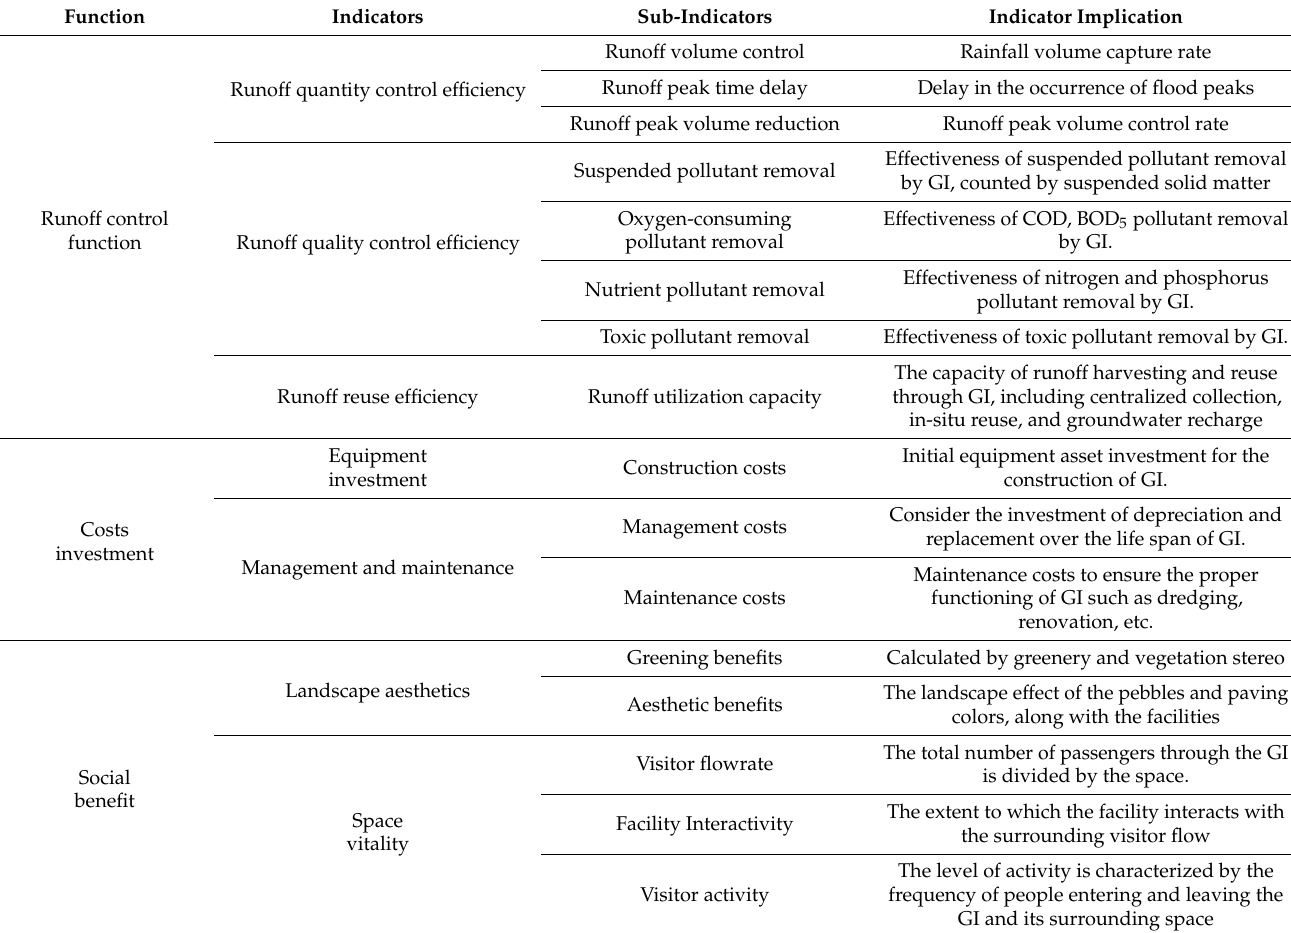
Table 3. Multi-function evaluation system for